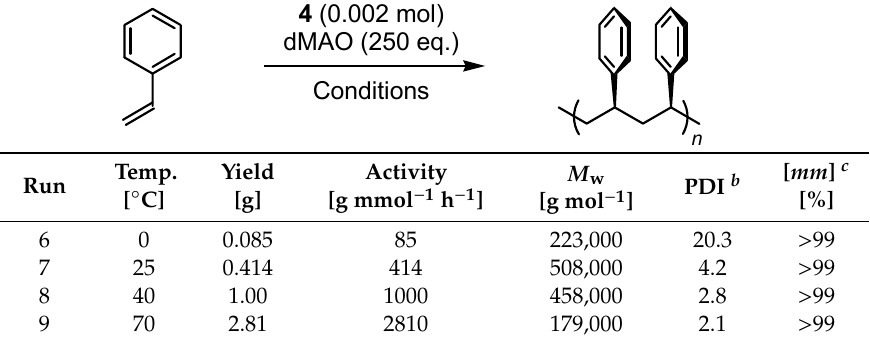
Table 2. Polymerization of styrene using precatalyst 4 activated with dMAO a .